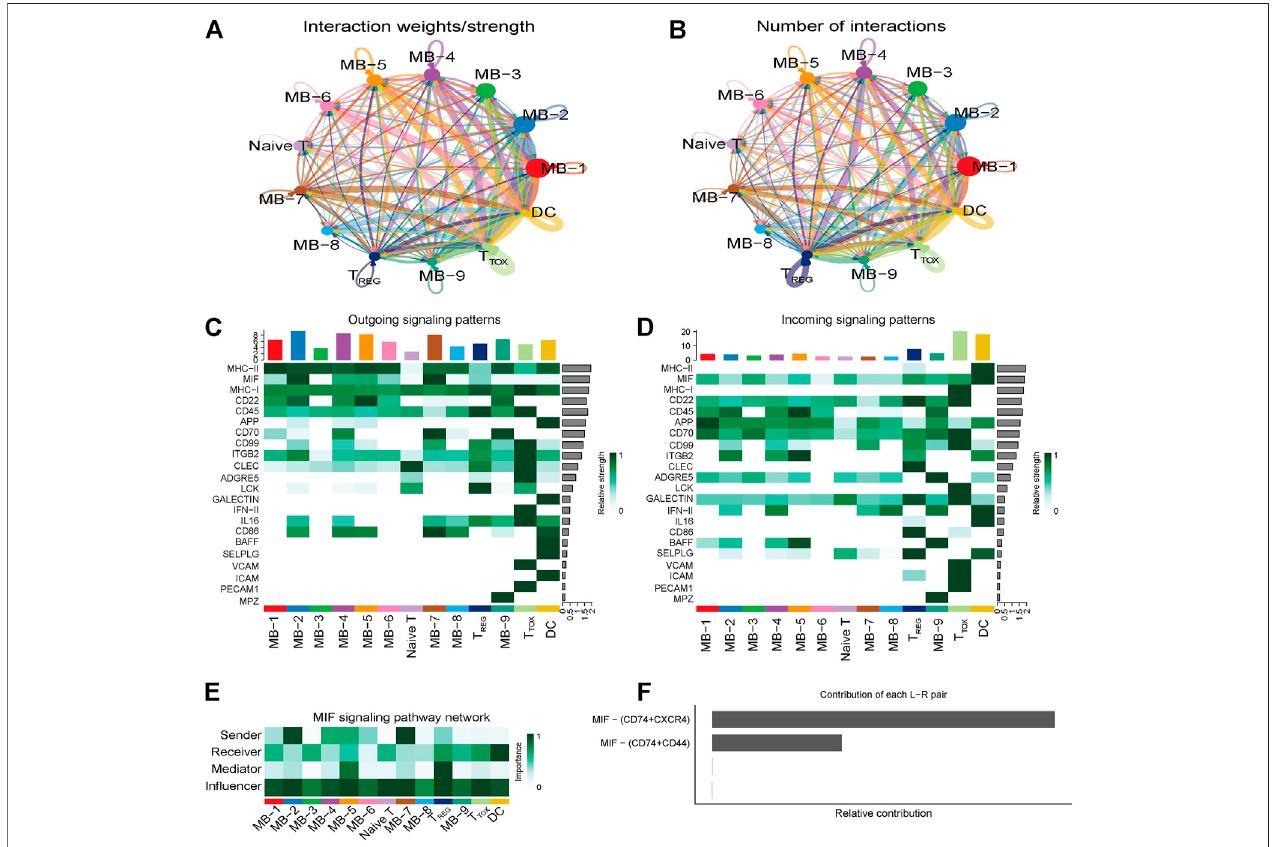
FIGURE4| CellularcommunicationinDLBCL. (A,B) Circlediagramshowingthenumberofinteractionsorstrengthofinteractionsbetweenanytwogroupsofcells. (C,D) Heat map of the cell-cell communication network for incoming or outgoing signaling action analysis. (E) Heat map showing the relative importance of each cell group based on the four network centrality degrees of the calculated MIF signaling network. (F) Relative contribution of each ligand-receptor pair to the overall communication network of the MIF signaling